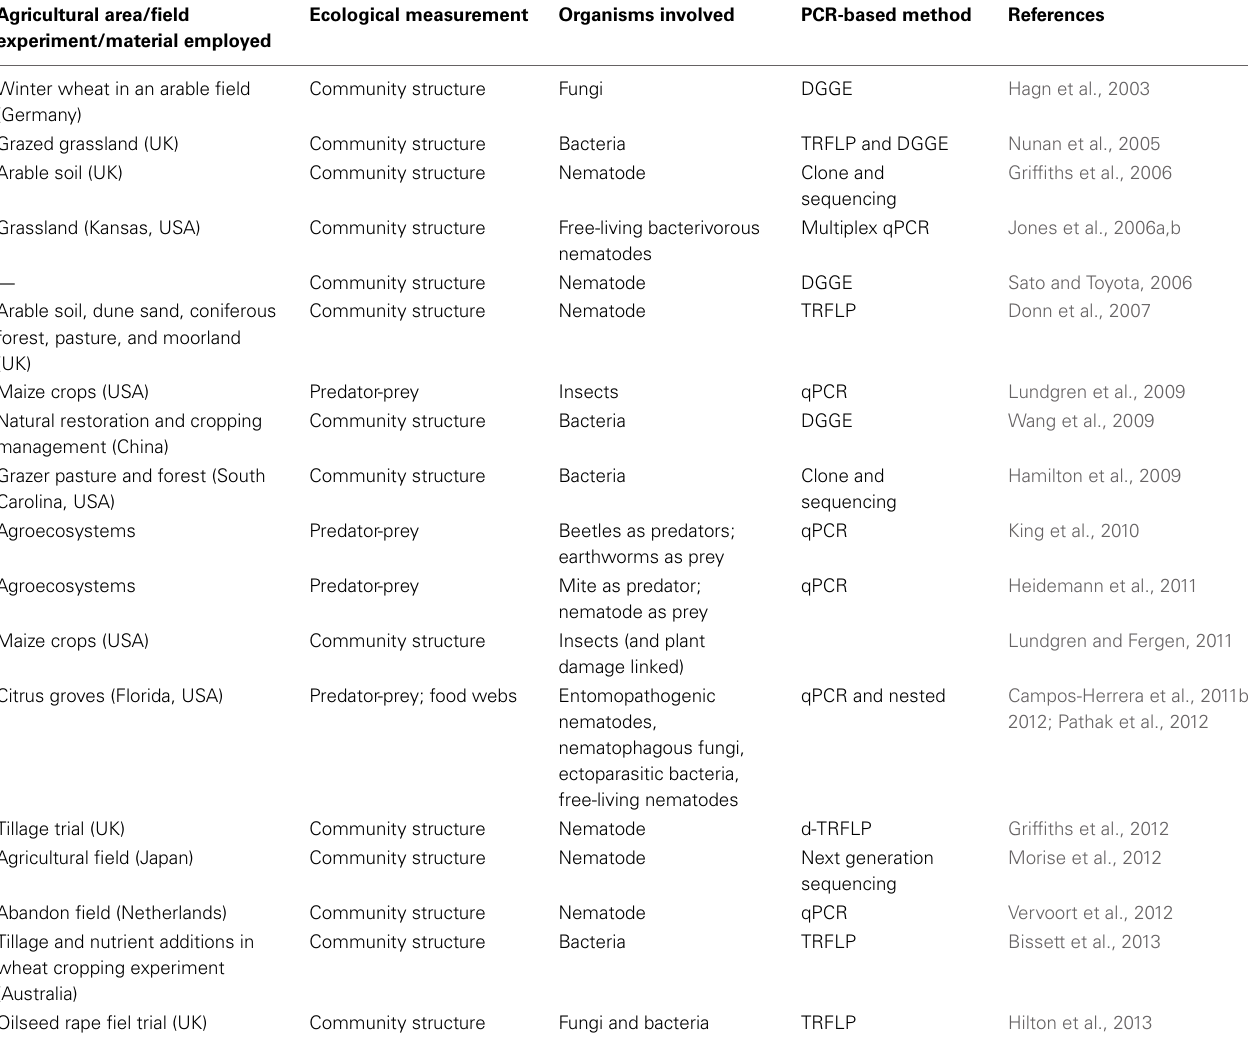
Table 1 | Examples of belowground studies using PCR-based methods for agricultural